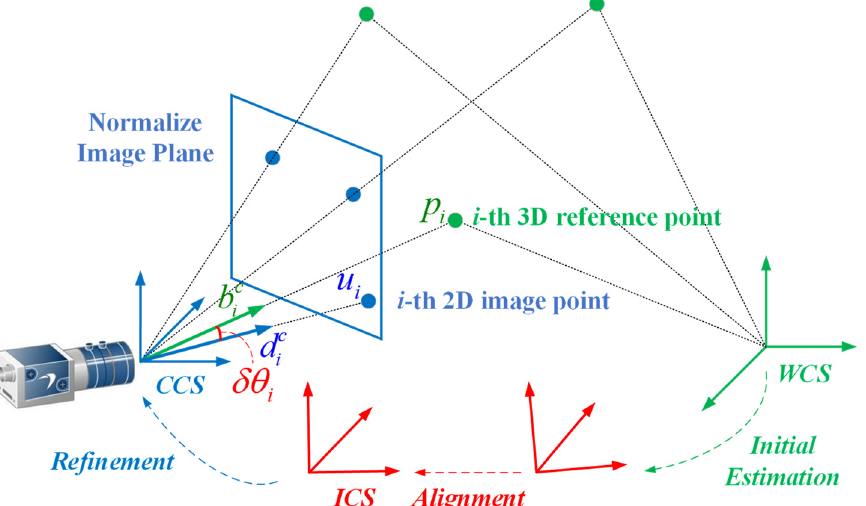
Figure 1. Formulation of pose determination. Note that, although a perspective camera is used here, the proposed algorithm can be used for any type of central cameras.